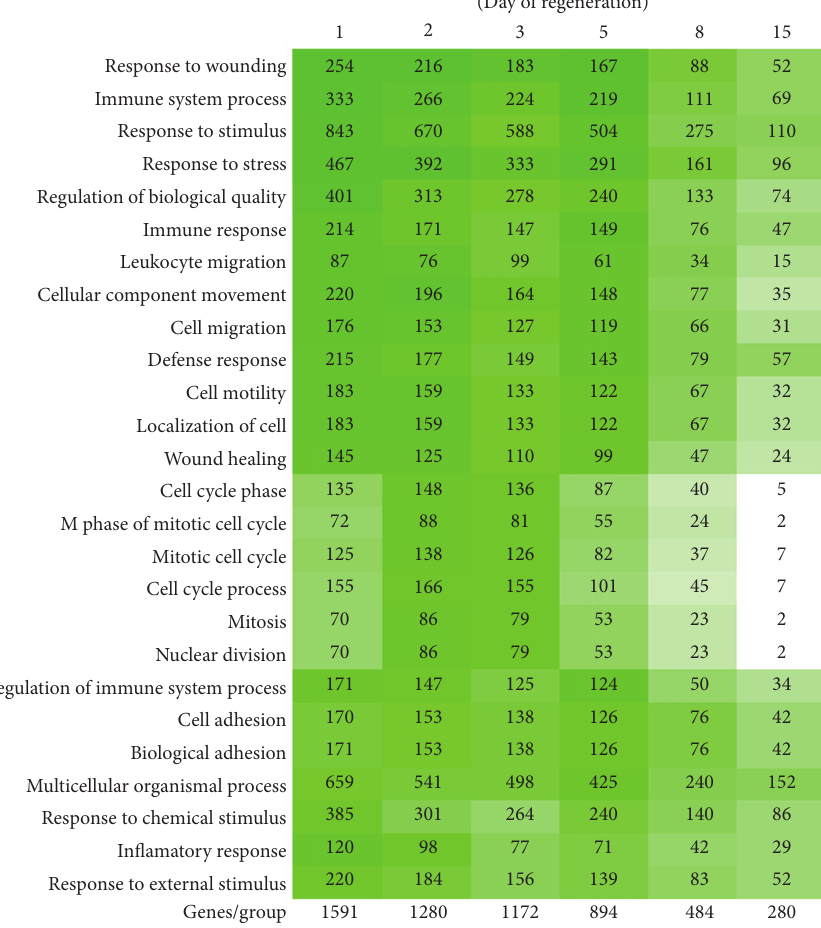
Figure 1: Affymetrix Rat Gene 1.1 ST Array. Ontology analyses of up-/downregulated genes (fold > 2, 𝑃 < 0.05 ) using GeneAnswer (part of the R project) based on Gene Ontology database. On the left side functional categories were placed, on the bottom of the graph—total number of genes up-/downregulated during adrenal regeneration. Genes with changed expression (fold > 2, 𝑃 < 0.05 ) compared to control were grouped in functional categories. In each category hypergeometric statistical test was performed. Green color—statistically significant changes of expression ( 𝑃 < 0.05 ). If 𝑃 value is lower, green color is more intense. It should be emphasized that GO database is composed of some general as well as specific categories with similar meanings and therefore a single gene may be mapped to several GO terms and may be counted more than